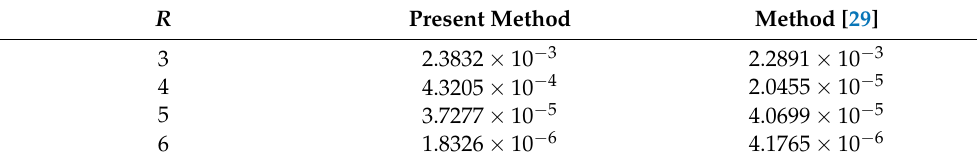
Table 3. Comparision of MAEs for Example 3 with the method given in [29] for different values of R